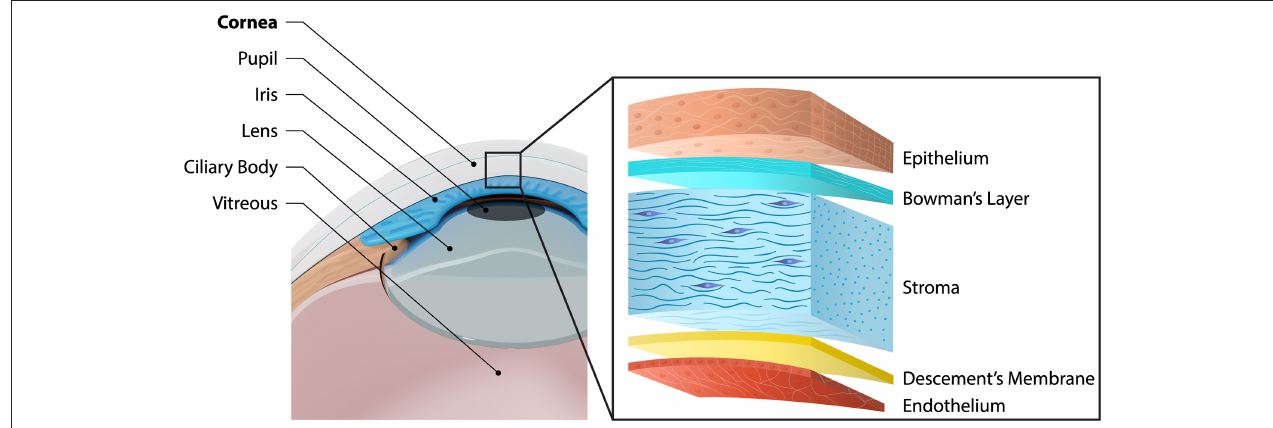
FIGURE 1 | Schematic diagram of the anatomical position of the cornea, and its 5 distinguishable layers.